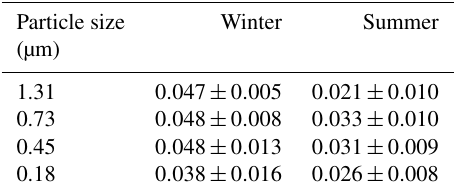
Table 3. Complex refractive index ( k ) of brown carbon from sam- ples extracted by water in two seasons.